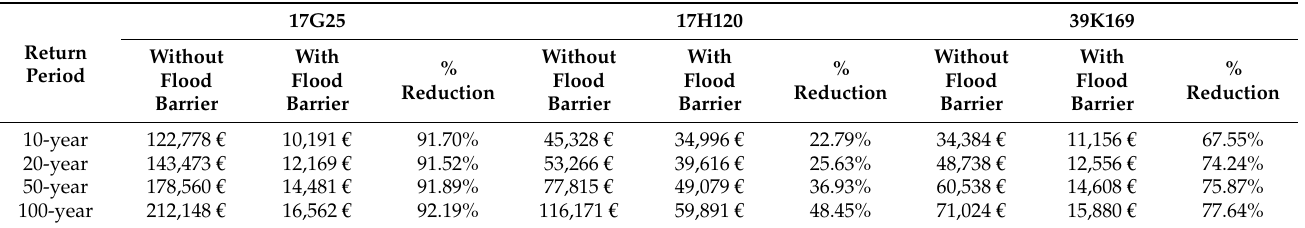
Table 3. Damage estimation for manholes with and without flood protection barriers for all return periods in Euros [ € ].